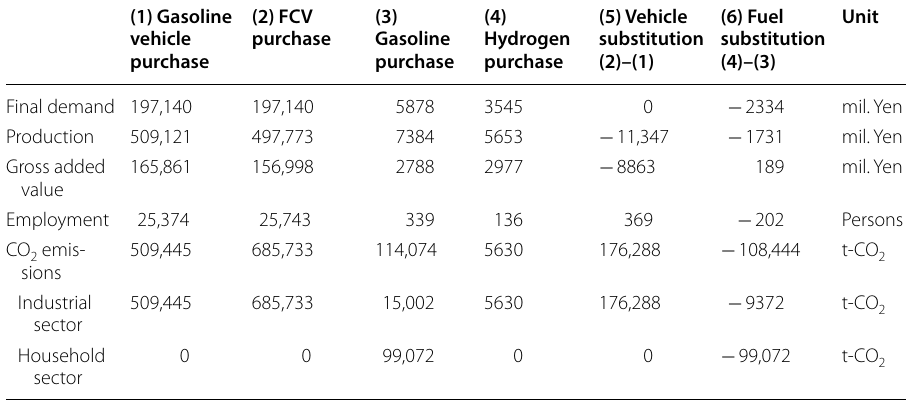
Table 11 Hydrogen production by direct decomposition of methane method. Source : Authors’ calculation